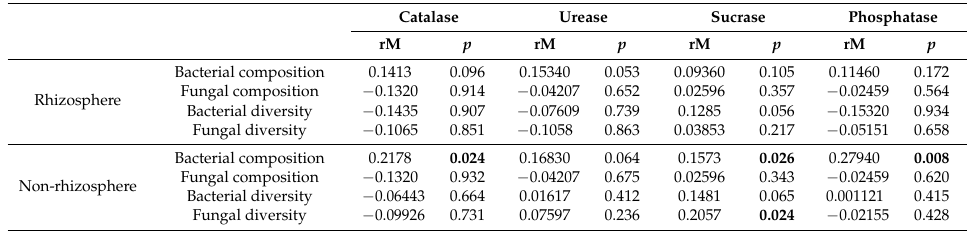
Table 5. Relationships of microbial compositions and diversities to different soil enzyme activities by a Mantel Table 4. Two-way ANOVA of microbial diversity and microbial gene abundances of rhizosphere and non-rhizosphere soil in different sub-dams. df